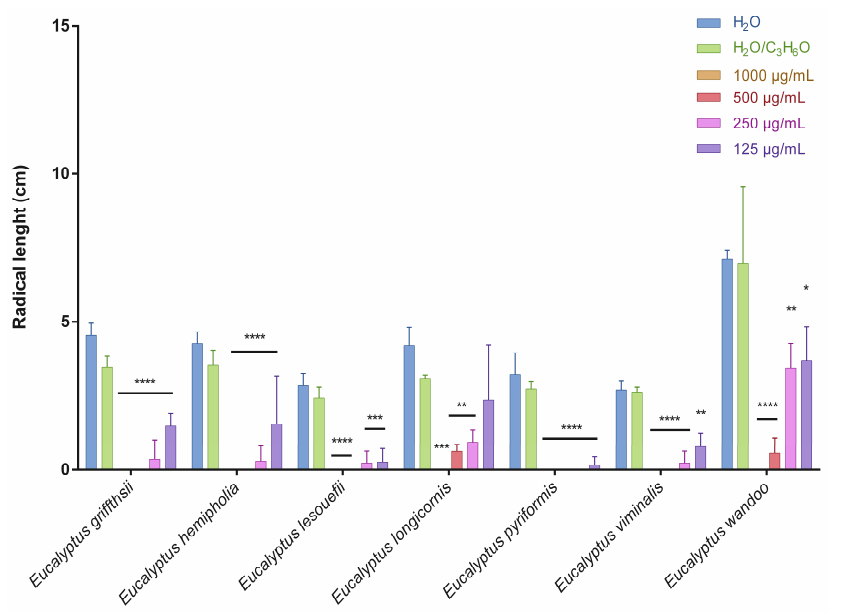
Figure 2. Radical length of Sinapis arvensis seeds after treatment with different concentrations (125–1000 µg/mL) of Eucalyptus essential oils measured 120 h after sowing. Results are the mean ± standard deviation ( n = 3) of three independent experiments. * p < 0.05; ** p < 0.01, *** p < 0.001, **** p < 0.0001 compared to control (ANOVA followed by Dunnett’s multiple comparison